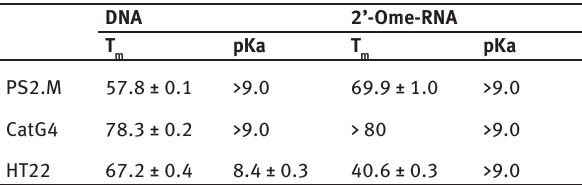
Table 2: Melting temperatures (T (pKa) for the system containing G4 DNA and their 2’-OMeRNA